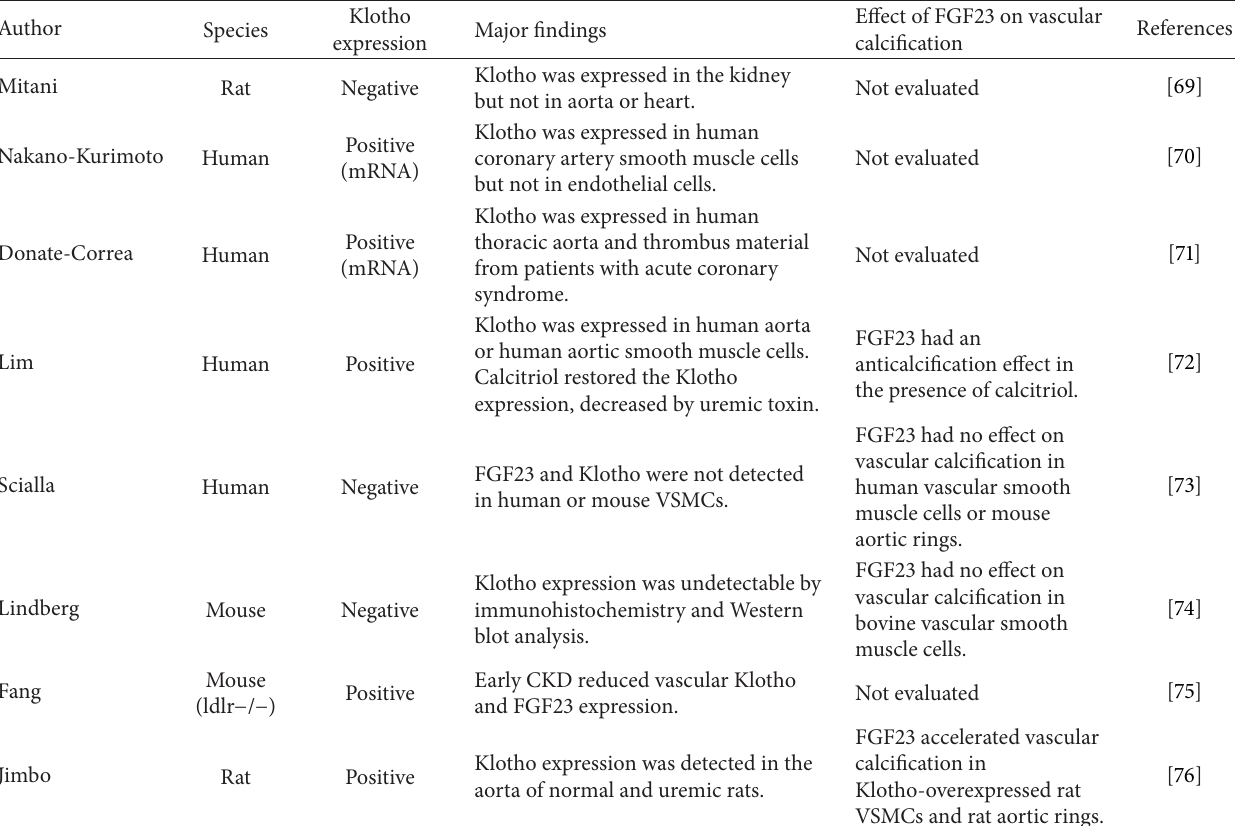
Table 1: Klotho expression in the